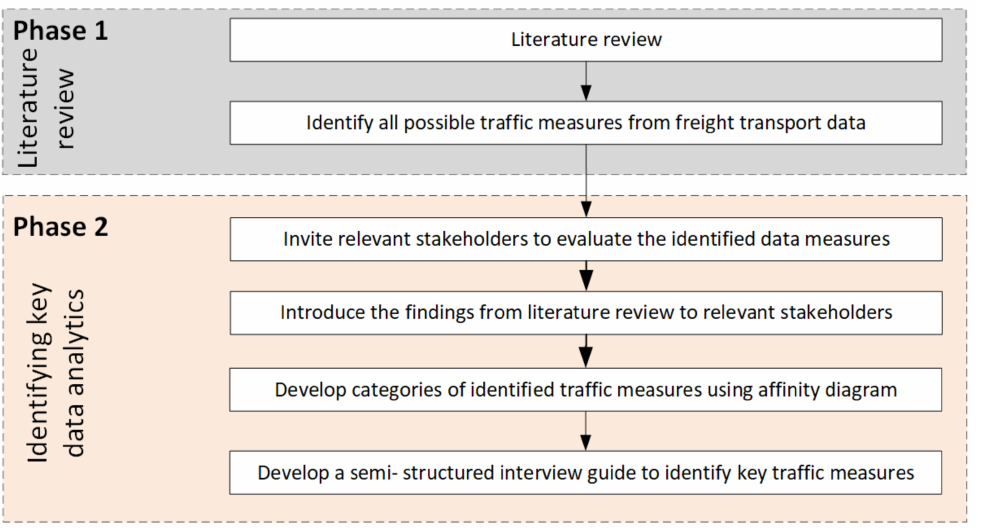
Figure 2. The proposed requirements gathering